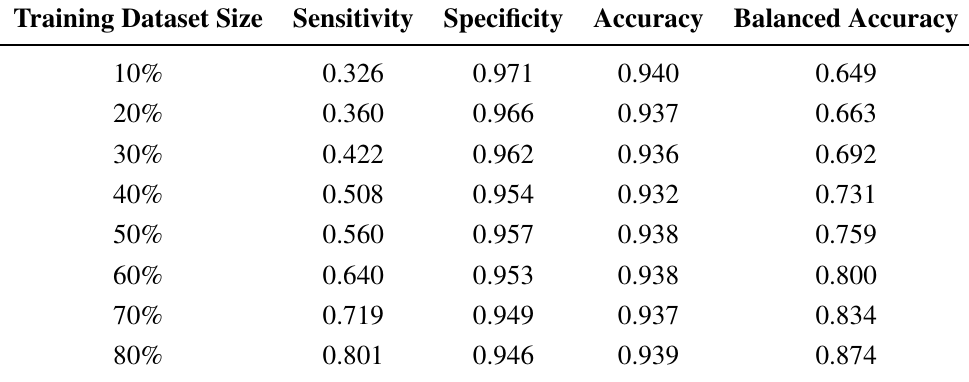
Table 4. Prediction performance with different training dataset sizes. The training dataset is composed of 10%, 20%, ..., 80% of the whole positive dataset and 10%, 20%, ..., 80% of the whole negative dataset,